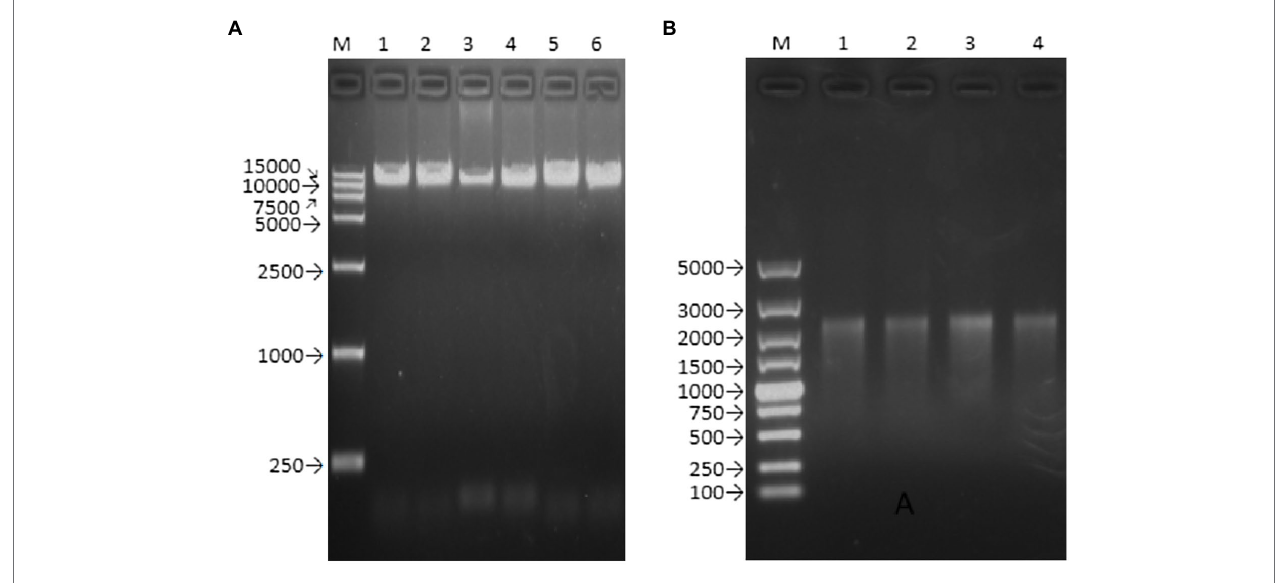
FIGURE 2 | Agarose gel electrophoresis of PCR product and transcript of rZKC2. (A) Full-length PCR product containing the whole ZIKV genome (with a T7 promoter and HDVr at the end of the 5 ' UTR and 3 ' UTR, respectively; (B) Full-length transcript from the purified full-length PCR